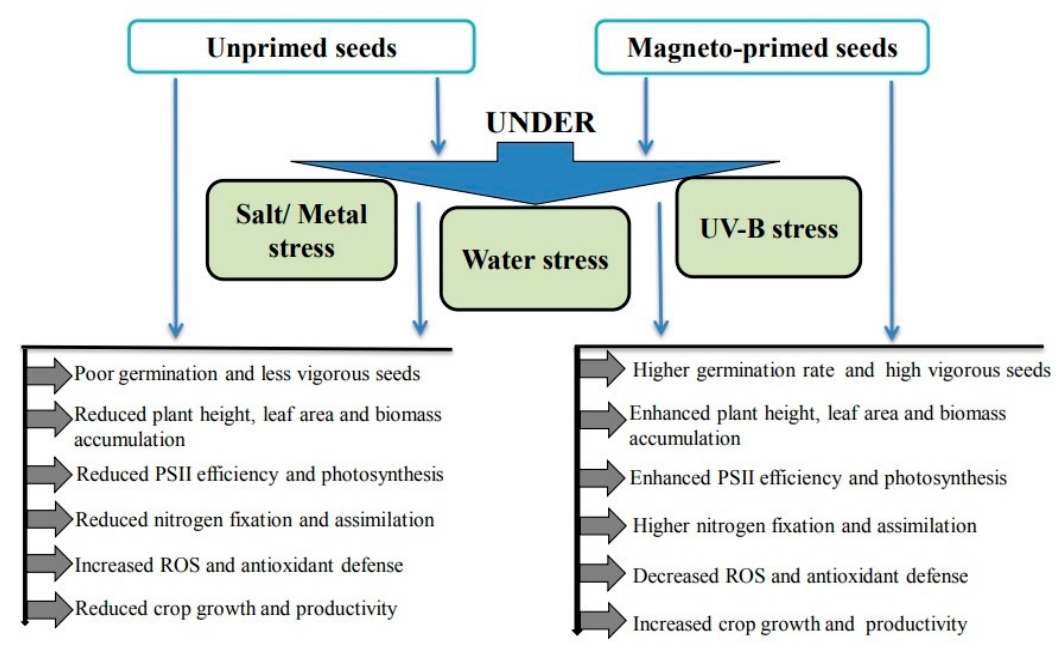
Figure 1. The e ff ect of magnetic field treatment on plants’ abiotic Figure 1. The effect of magnetic field treatment on plants’ abiotic stresses.